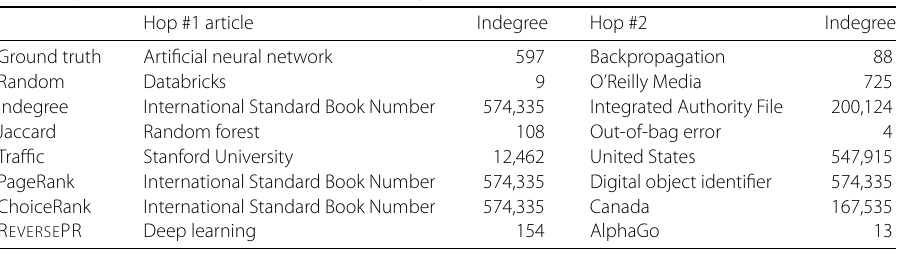
Table 4 Articles most likely to be visited in a 2-hop session and their respective in starting from three different Wikipedia articles according to the various